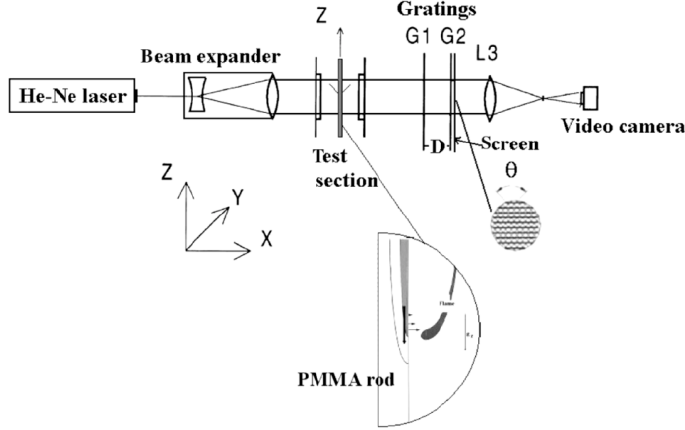
Figure 16. Experimental arrangement for Moire deflectometry